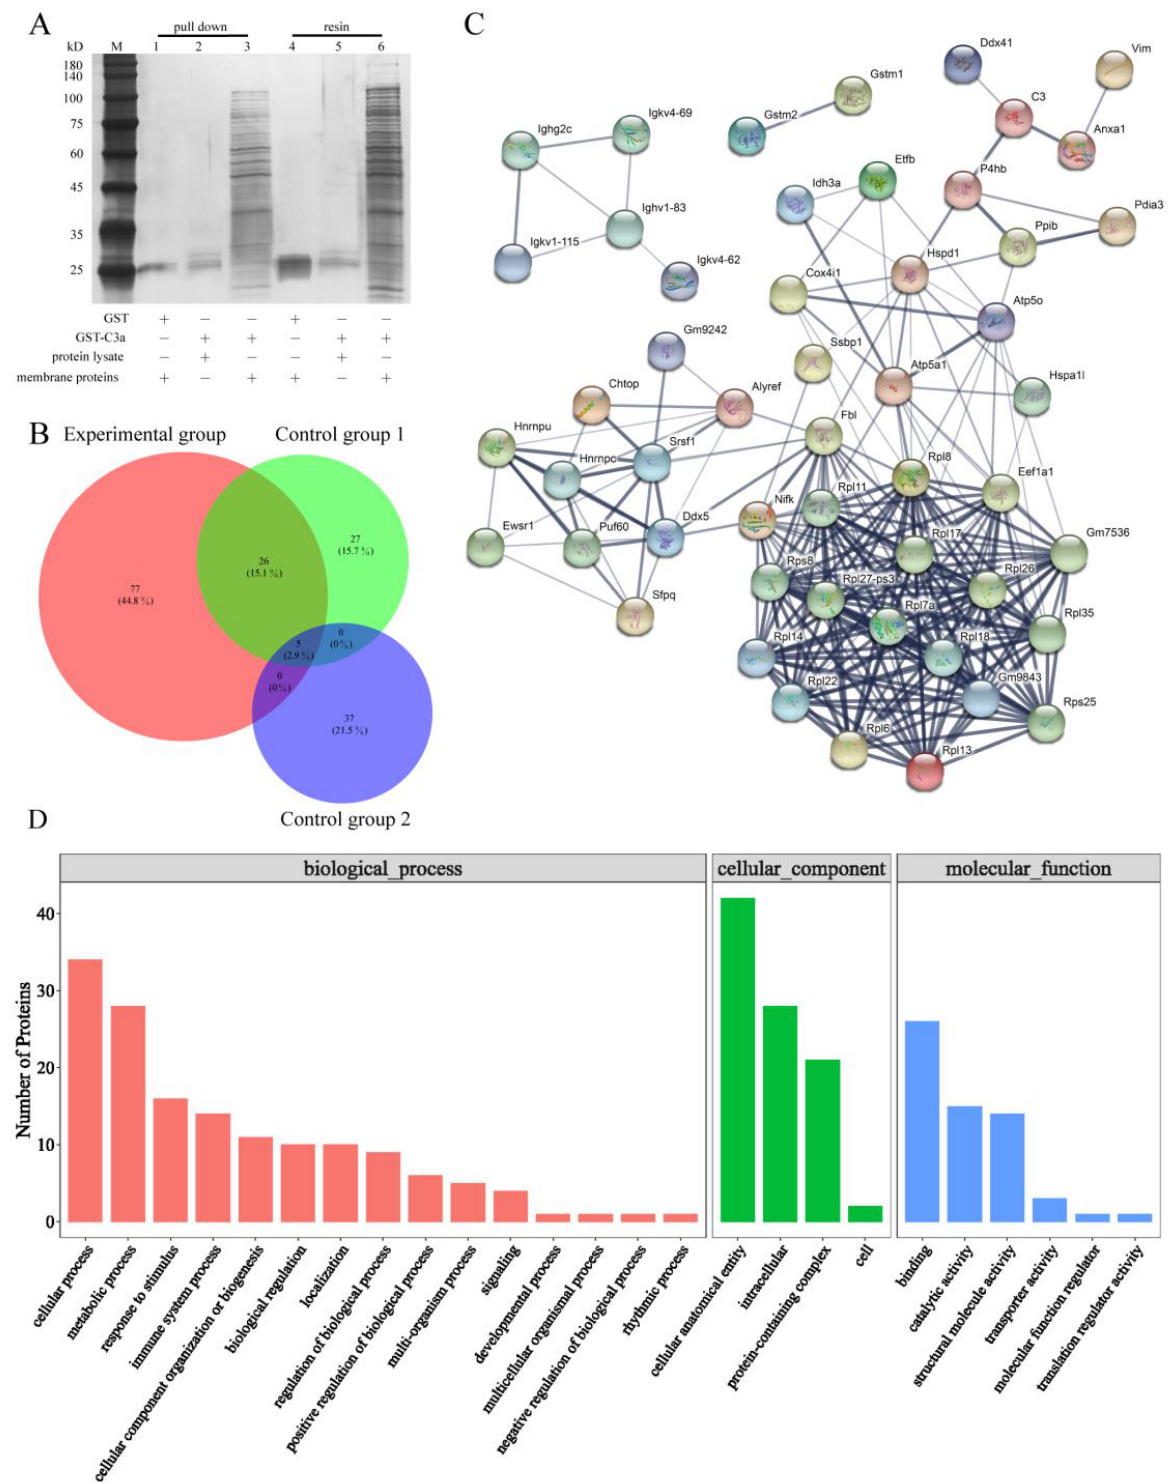
Figure 4. Anxa1 was screened as a protein that directly act on C3a. ( A ) Silver staining via Flag-tagged pulldown confirmed that C3a interacted with various membrane proteins from bEnd3 cells. ( B ) The Wayne figure of proteins in control group 1, control group 2 and experimental group. ( C ) STRING interaction network of the unique proteins of the membrane proteins from bEnd3 cells which was derived from the STRING database. ( D ) GO functional enrichment analysis of the unique proteins of the membrane proteins from bEnd3 cells.